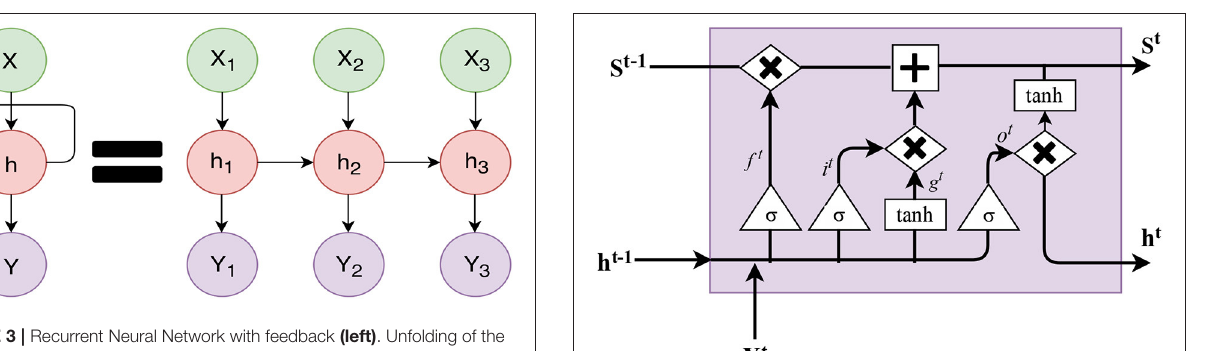
FIGURE 3 | Recurrent Neural Network with feedback (left) . Unfolding of the Recurrent Neural Network (right) : The X values are the inputs (past values of the signal). Y values are the predictions. Each successive X is considered when predicting the next Y value. For instance Y 1 is predicted based on h 1 , but Y 2 is predicted based on both h 1 and h 2 , and X 2 .